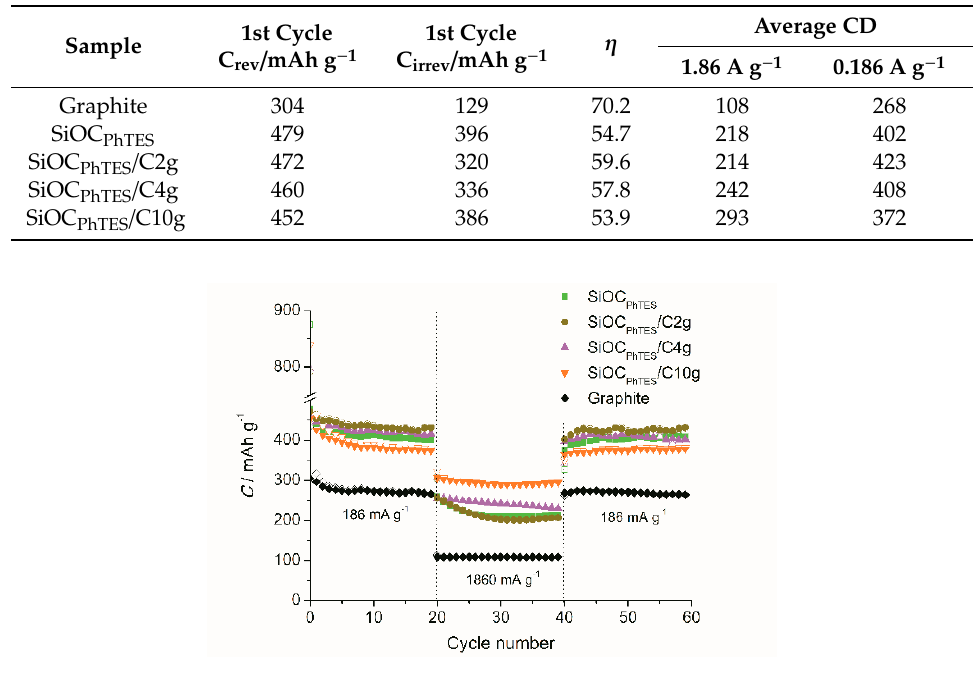
Figure 9. Lithiation (empty symbol) and delithiation (solid symbol) capacity upon extended cycling at C/2 and 5C rate for the investigated materials.